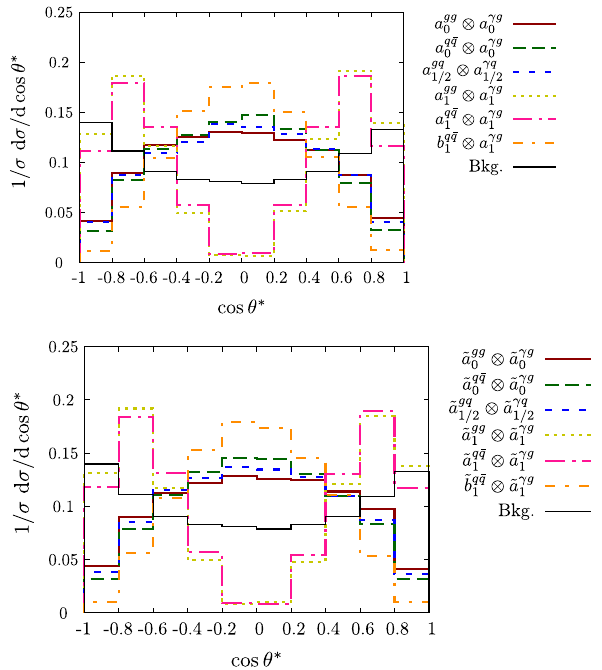
Fig. 4 Normalisedcos θ ∗ distributionforjet+ γ productionforvarious spin and couplings (not considering detector resolution or jet-merging effects). The distributions do not allow one to discriminate between the P/CP properties of the interactions